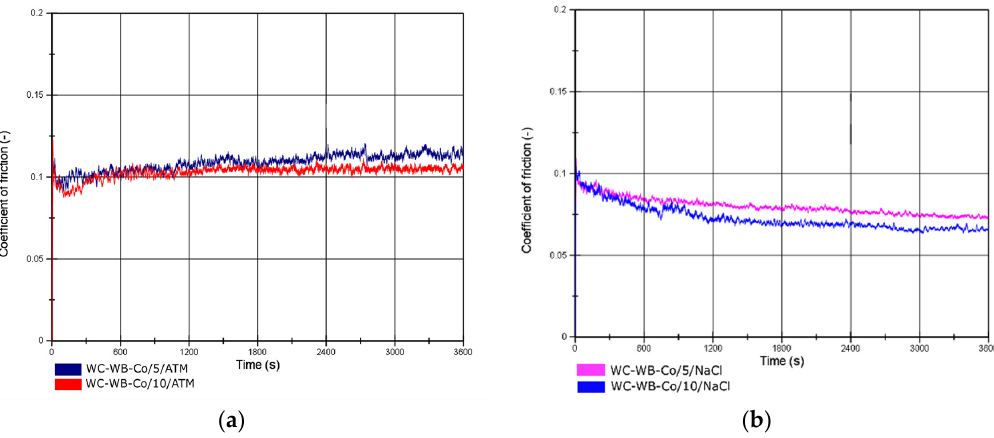
Figure 14. WC ‐ WB ‐ Co coating: ( a ) friction coefficient in dry friction, and ( b ) friction coefficient in sodium chloride (NaCl) solution.